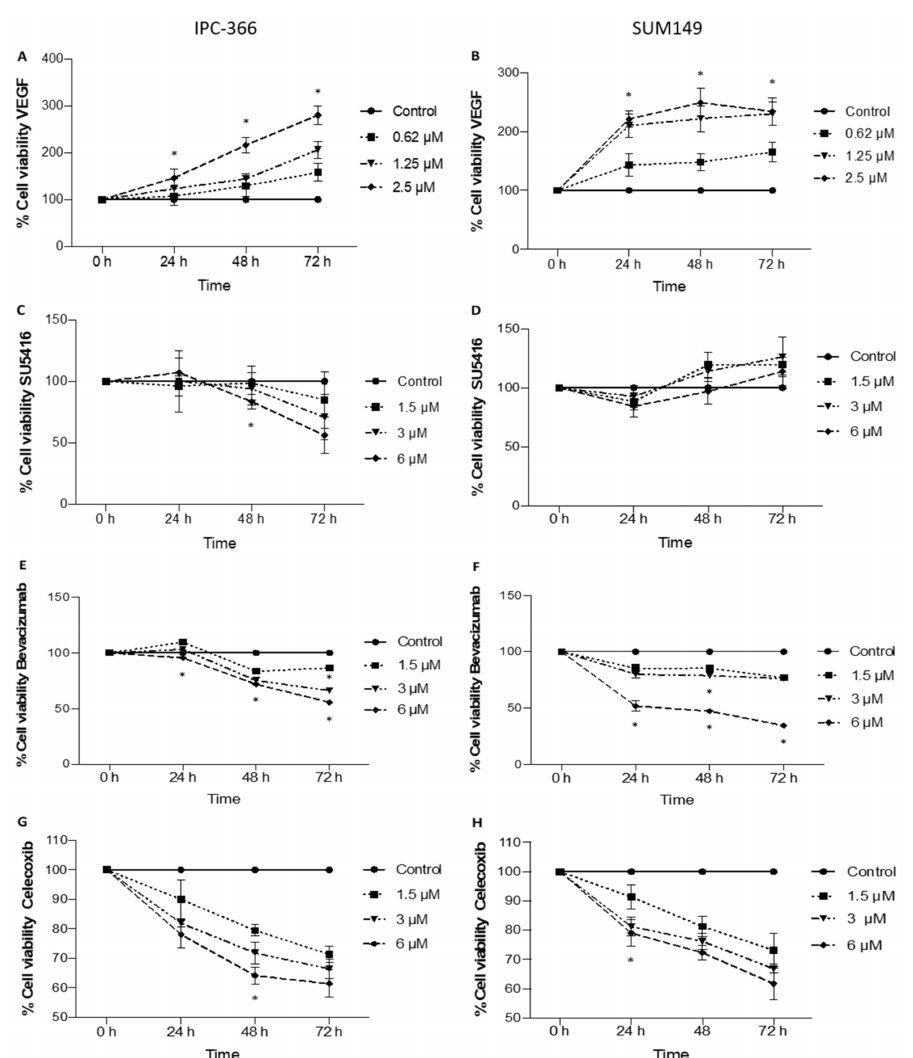
Figure 1. In vitro VEGF (0.62, 1.25, 2.5 uM), SU5416, bevacizumab and celecoxib (1.5, 3, 6 uM) effects on cell viability after 24 h, 48 h and 72 h post-treatment in IPC-366 and SUM149 cell lines measured by MTS assay. Cell viability increases after VEGF addition in both cell lines ( A , B ). Cell viability decreased after SU5416 treatment in IPC-366 cells and increased in SUM149-treated cells ( C , D ). Decreased cell viability in IPC-366- and SUM149 treated cells after bevacizumab ( E , F ) and celecoxib ( G , H ) addition. Data are shown as means ± SEM. * Significant differences between control and treated groups ( p <